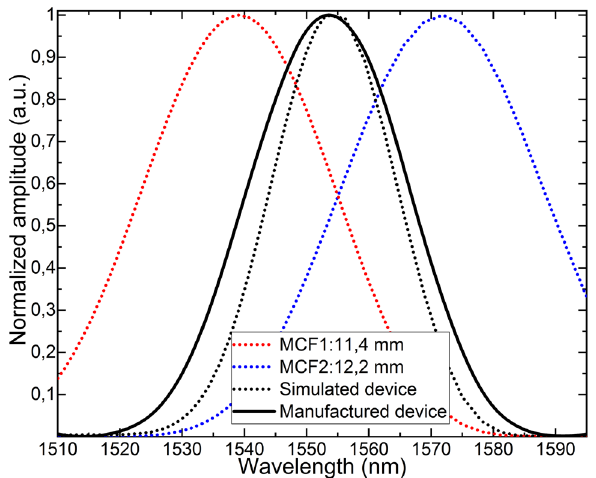
Figure 4. Normalized spectra of the simulated (black dashed line) and manufactured devices (black continuous line). Notice that the maxima of both curves is around 1554 nm and there are no secondary lobes. Simulated spectra of MCF segments of 11.4 mm (red dashed line) and 12.2 (blue dashed line) are shown as well. As indicated in Eq. (2) their product results in the black dashed